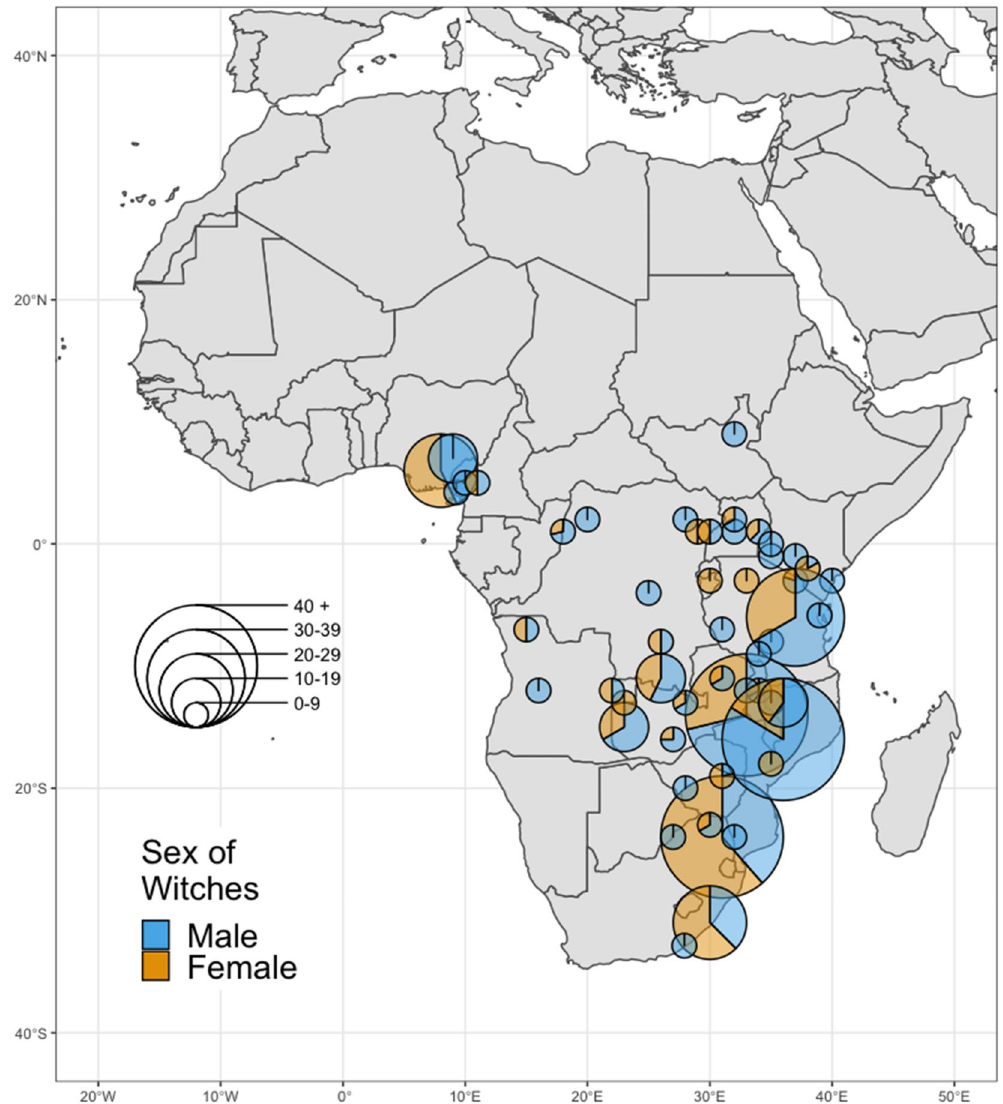
Figure 2. Map showing the location of societies used in the study. Each pie chart represents the percentages of accused men and women making up the total cases in a society. The sample size for each society is illustrated by the size of the pie chart. This was produced using R version 4.0.3 43 with the packages ggplot2 44 , ggmap 45 and scatterpie 46